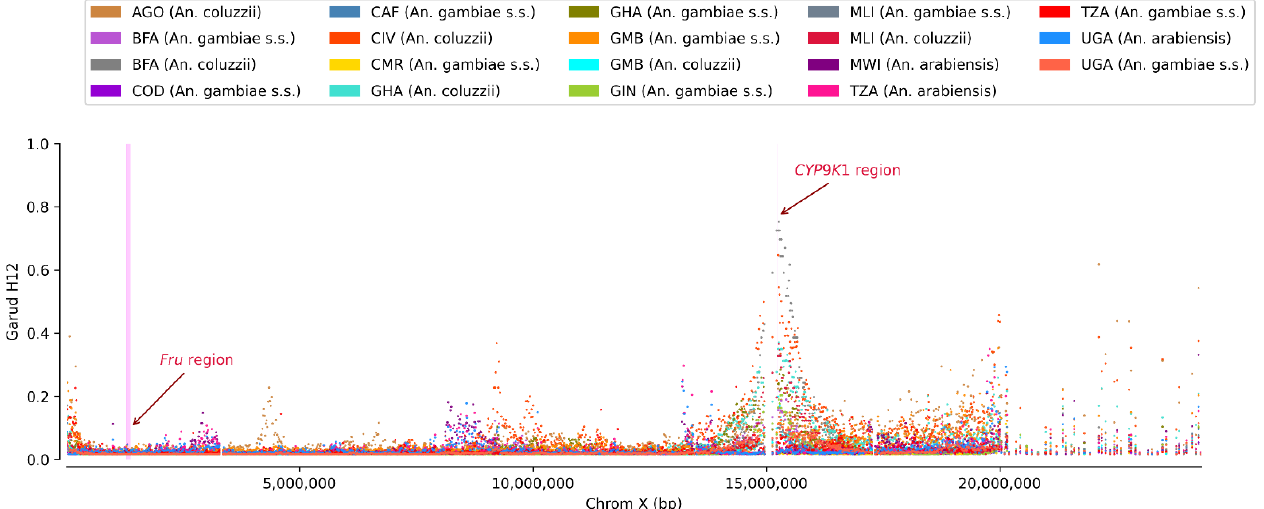
Figure A5. H12 statistic in chromosome X (window size = 4 kb) of An. gambiae s.l population. High values of H12 in a given genomic region indicates a signal of positive selection in this genomic region within the population [36]. Magenta bands indicate the fru region (X: 1283016-1373662) and the Cyp9k1 region (X:15240572-15242864). The H12 values were low in the fru region, but higher in the Cyp9k1 region shown to be involved in the pyrethroid resistance in An. gambiae s.l populations [42]. AGO: Angola; BFA: Burkina Faso; CAF: Central African Republic; CIV: C ô te d’Ivoire; CMR: Cameroon; COD: Democratic Republic of Congo; GHA: Ghana; GIN: Guinea; GMB: Gambia; MLI: Mali; MWI: Malawi; TZA: Tanzania; UGA: Uganda.